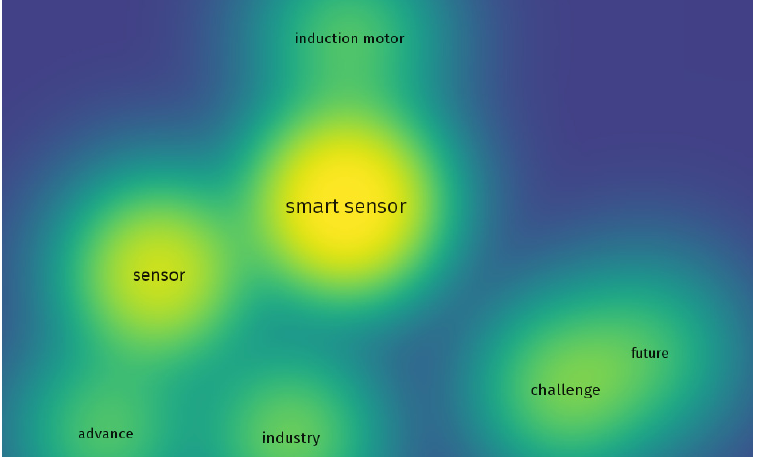
Figure 6. VOS viewer network connection density.